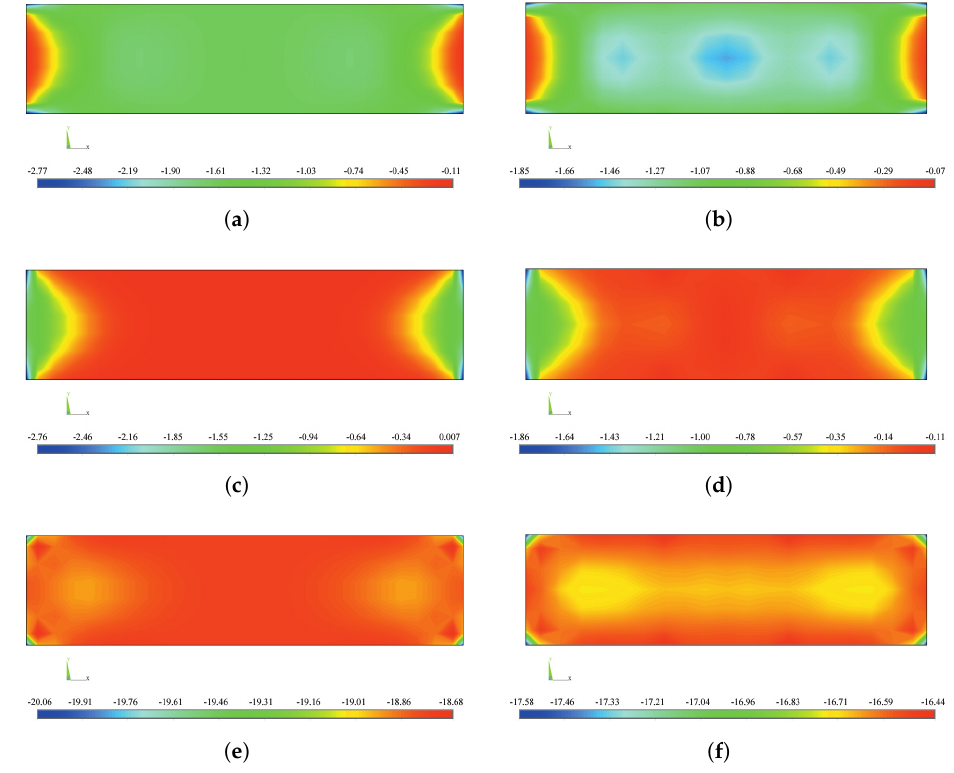
Figure 8. Stresses contour plot of columns II4 and S02C at the peak axial force in longitudinal x direction ( a , b ), in transverse y direction ( c , d ), and in vertical z direction ( e , f ). Table 4. Performance of the numerical FEM models in axial load capacity assessment.